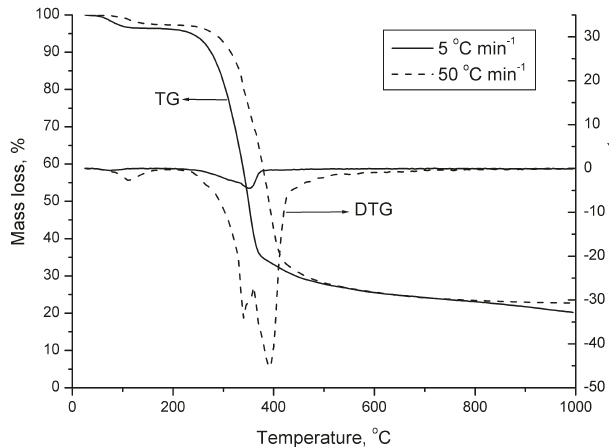
Figure 2. Thermogram of spruce wood obtained with heating rates 5 and 50°C min -1